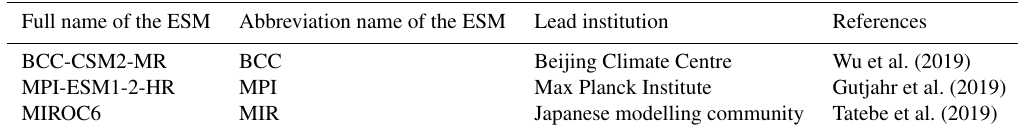
Table A1. Full name, abbreviation name, lead institution, and references of the Earth system model (ESM) used in this study. Full name of the